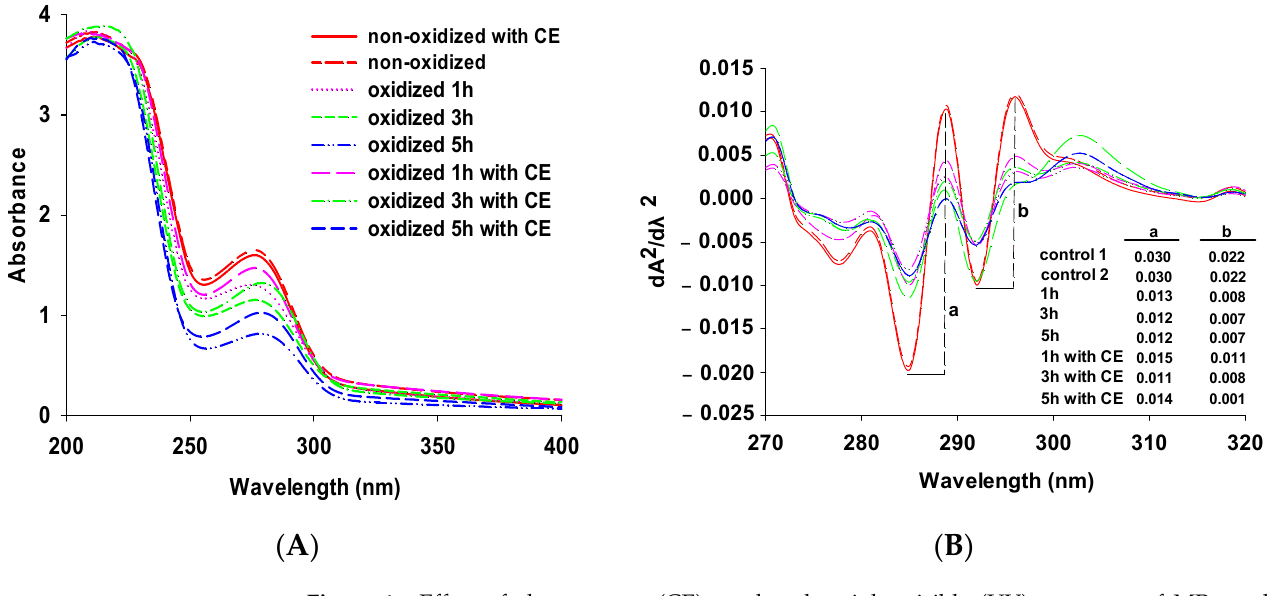
Figure 1. Effect of clove extract (CE) on the ultraviolet-visible (UV) spectrum of MPs under ( A ) different oxidation times and the spectrum of the second derivative of the UV scan ( B ). Letters “a” and “b” indicate the peak-to-valley values of the two main peaks. Control 1 means non-oxidized and Control 2 means non-oxidized with CE.